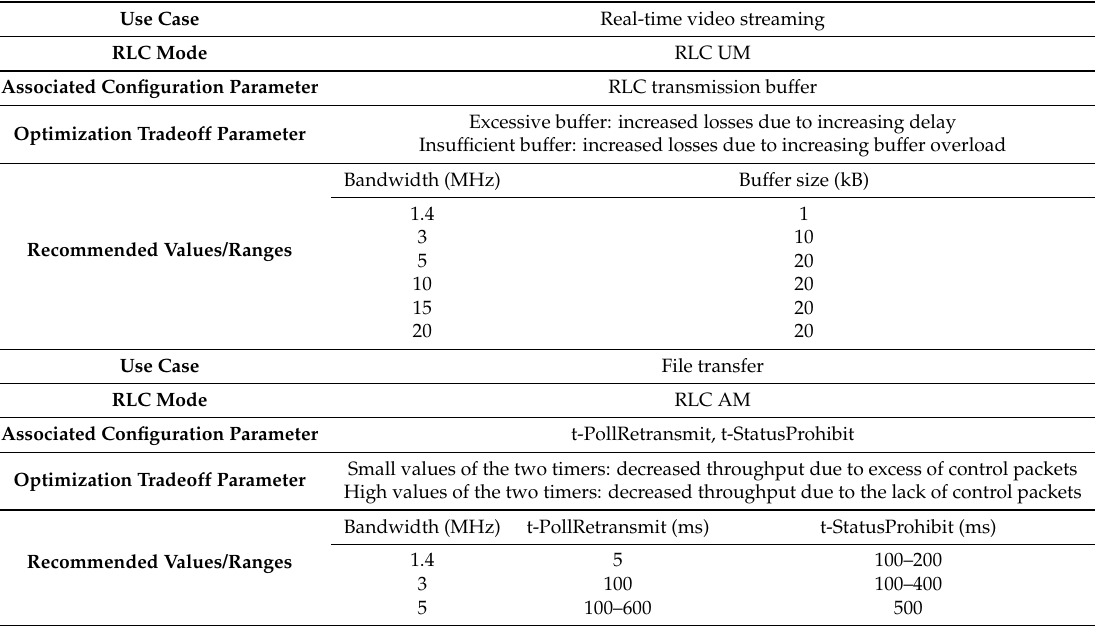
Table 2. Results